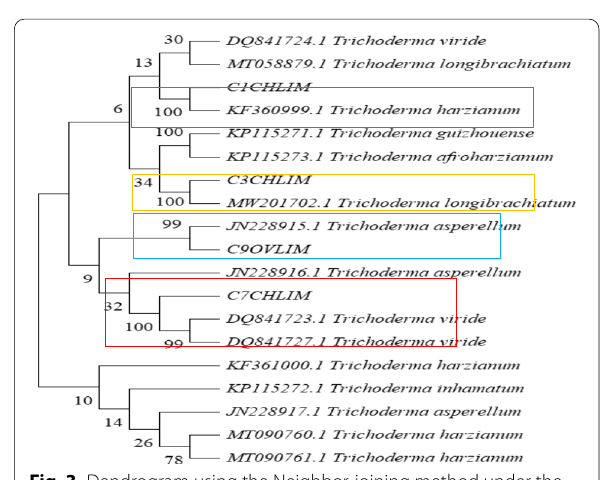
Fig. 3 Dendrogram using the Neighbor‑joining method under the Kimura 2‑parameter model of the sequences of the tef1 gene of Trichoderma